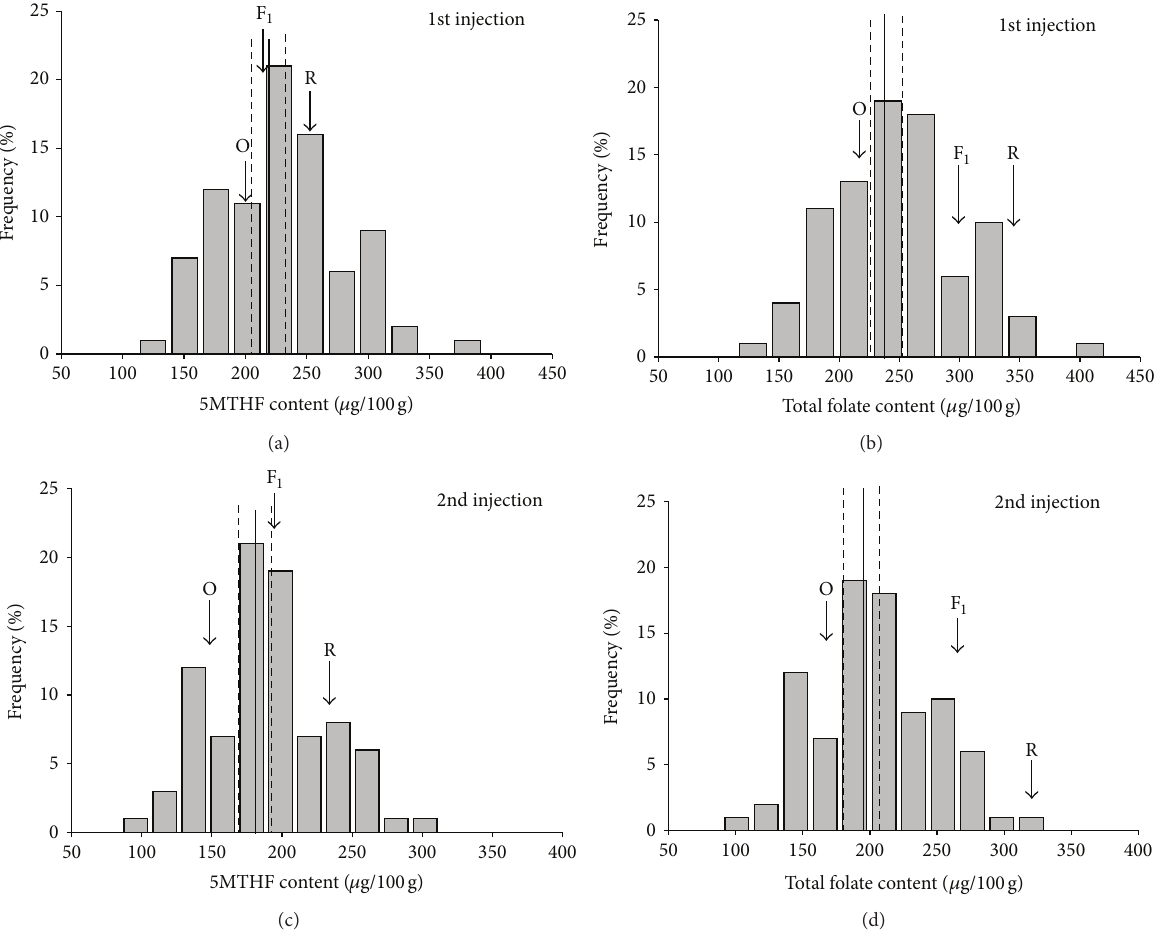
Figure 2: Relative frequency distribution of measurements of 5-methyltetrahydrofolate (5MTHF) and total folate content in the F 2 of Othello/Redhawk dry beans in the first ((a) and (b)) and second ((c) and (d)) injected solutions with one-hour time interval. Vertical lines indicate population mean and 95% confidence limits of the mean value in each plot, while arrows indicate the value for Redhawk (R), Othello (O), and their F 1